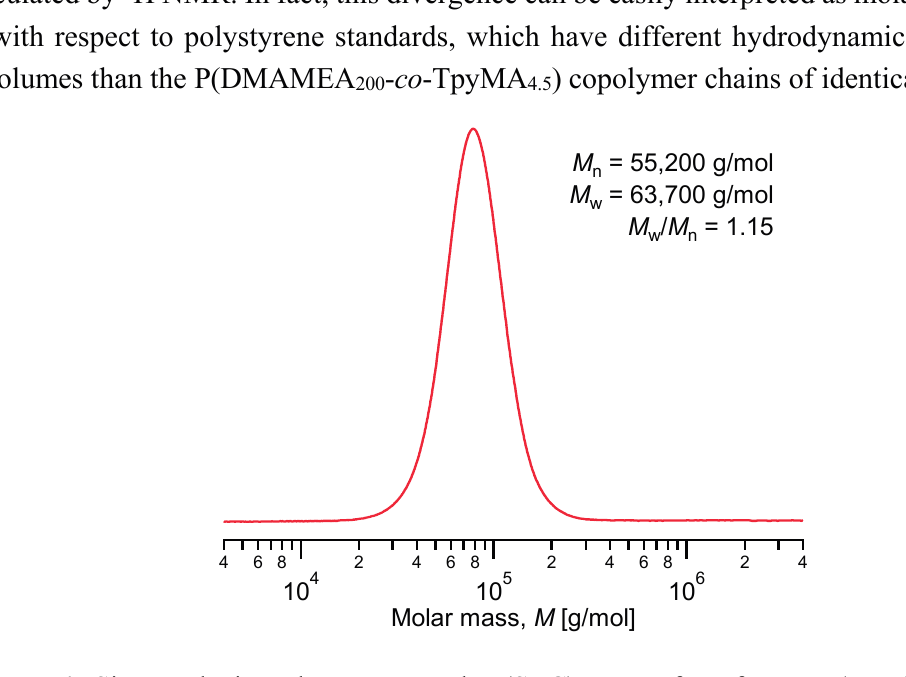
Figure 4. Size exclusion chromatrography (SEC) traces for of pure P(DMAMEA 200 - co - TpyMA 4.5 ) copolymer (molar masses are given with respect to polystyrene